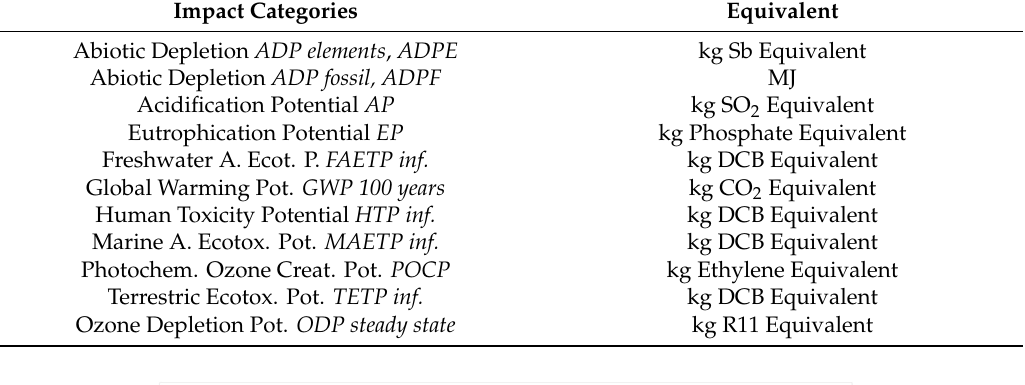
Figure 3. Relative contribution percentage of input-output materials and energy flows in the production stage. Table 1. The examined environmental impact categories [28,33].